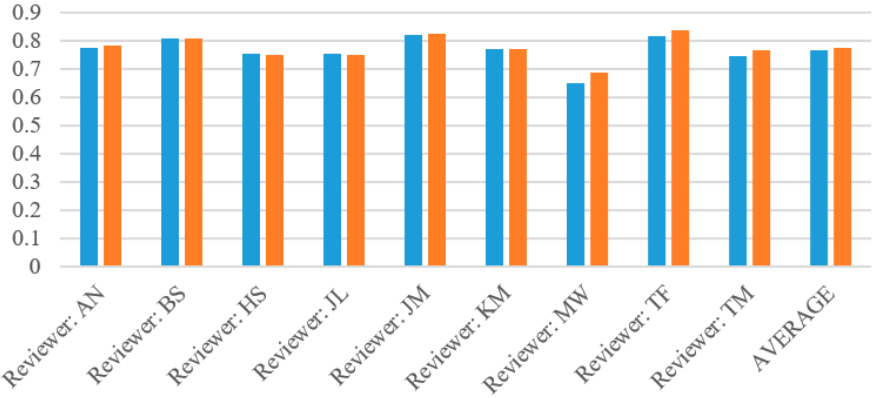
Figure 6. Precision for each reviewer with both original Naïve Bayes and Laplace.